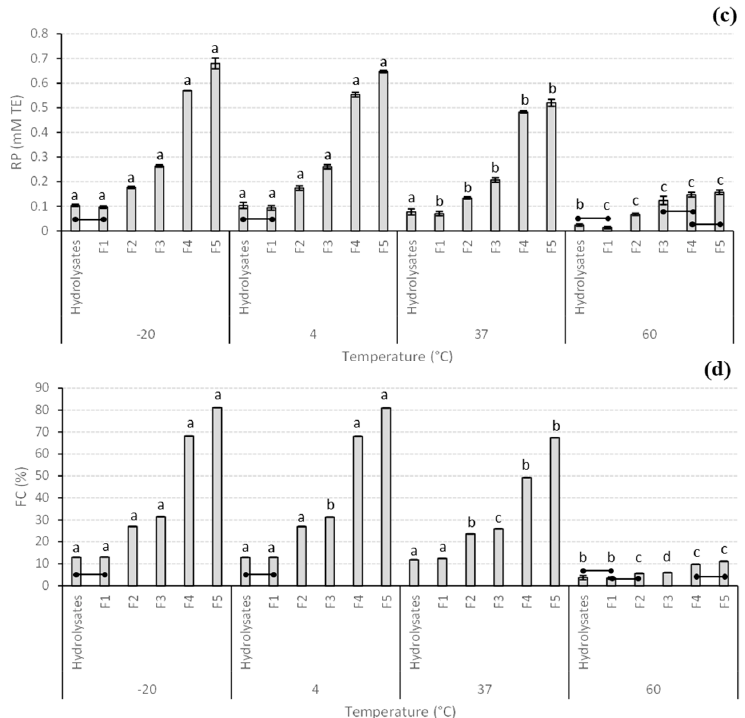
Figure 2. Stability of the biological activities in vitro ( a ) ACE inhibitory activity (%), ( b ) DPPH radical scavenging activity (%), ( c ) RP activity (mM TE) and ( d ) FC activity (%) of giant kelp protein hydrolysates and different MW fractions at various temperatures ( − 20, 4, 37 and 60 ◦ C). Data are presented as the average ± standard deviation ( n = 3). Different lowercase letters indicate statistical differences ( p < 0.05) in the biological activities in vitro of the same sample type at dif- ferent temperatures. Lines inside the figure join statistically similar ( p > 0.05) biological activities in vitro between different samples tested at the same temperature. Abbreviations in the figure are as follows: F1 (30 kDa > MW > 10 kDa), F2 (10 kDa > MW > 5 kDa), F3 (5 kDa > MW > 3 kDa),